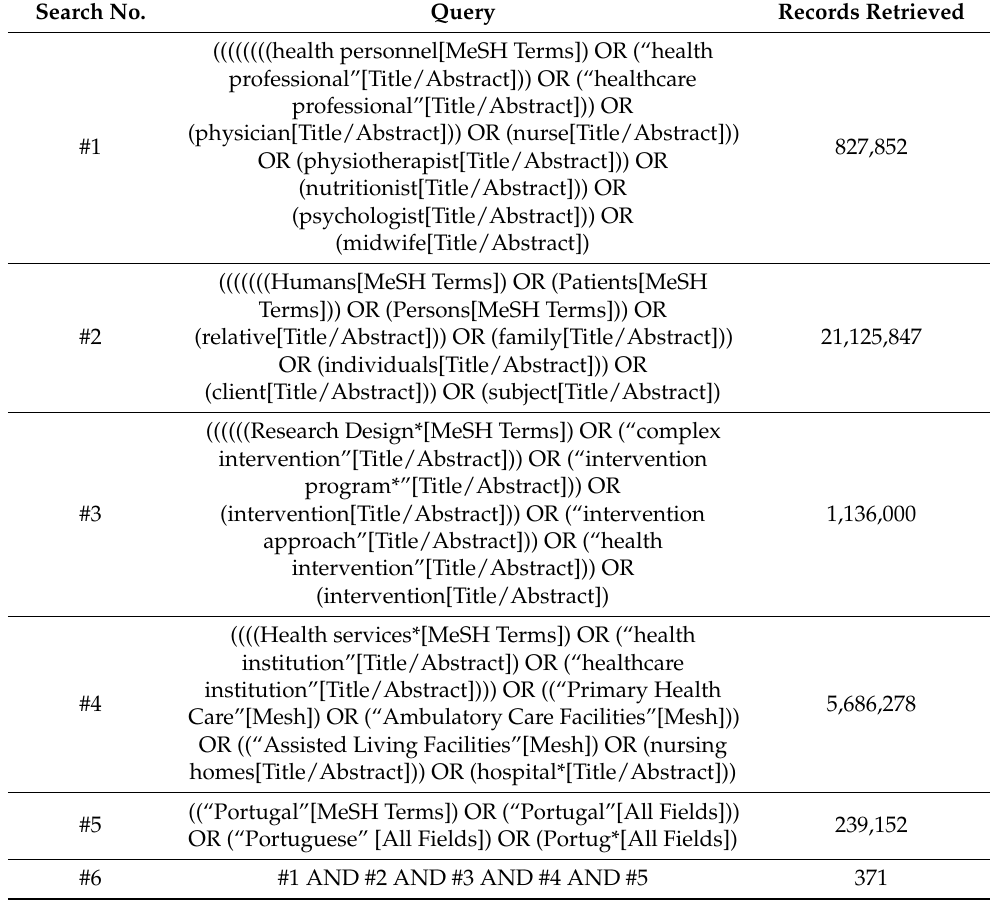
Table A1. Draft of search strategy to Medline (PubMed) 1